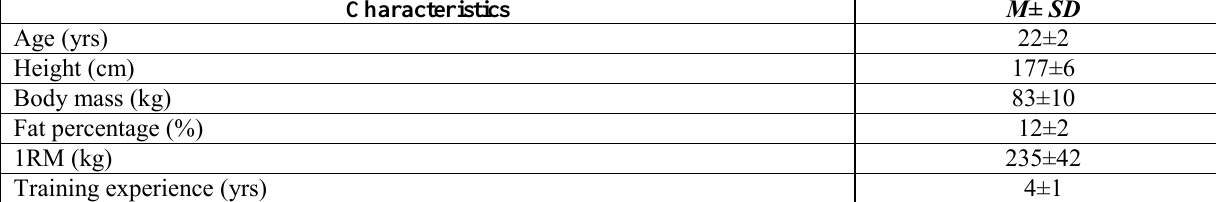
Individual characteristic: N = 10.Values = mean ± SD. 1RM = Maximal dynamic strength Characteristics